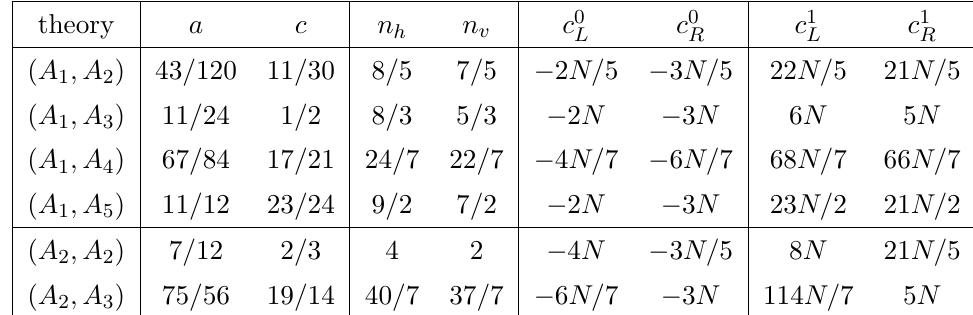
Table 6. 4d/2d central charges for Argyres-Douglas theories. Here ( c 0 n v )) and ( c 1 ; c 1 ) = ( n h + 2 n v ; (cid:0) 3 n v ). For the N -twist corresponding to the Tr M N , multiply the L R expression by (cid:0) N .